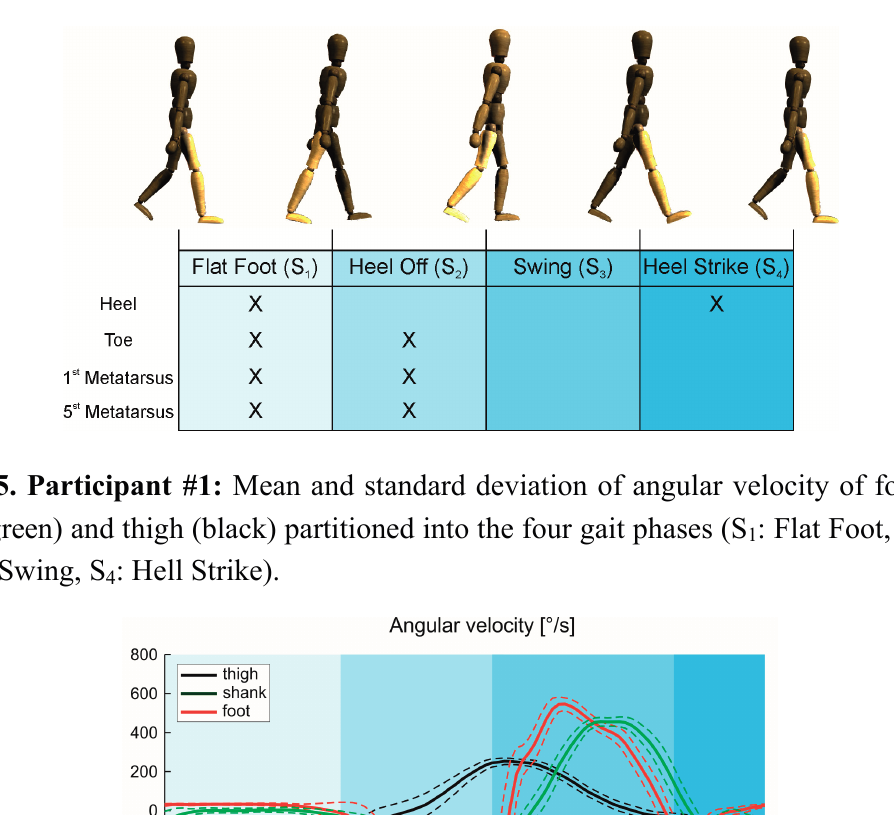
Figure 4. Combination of active foot switches, marked with X, to detect gait phases.